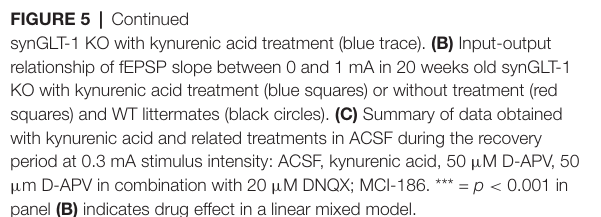
FIGURE 5 | Continued synGLT-1 KO with kynurenic acid treatment (blue trace). (B)